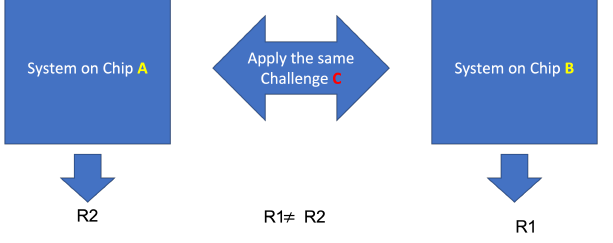
Figure 2. Two identical PUF circuits on two different chips generate different